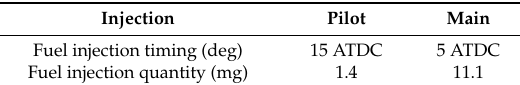
Table 5. Fuel injection condition.